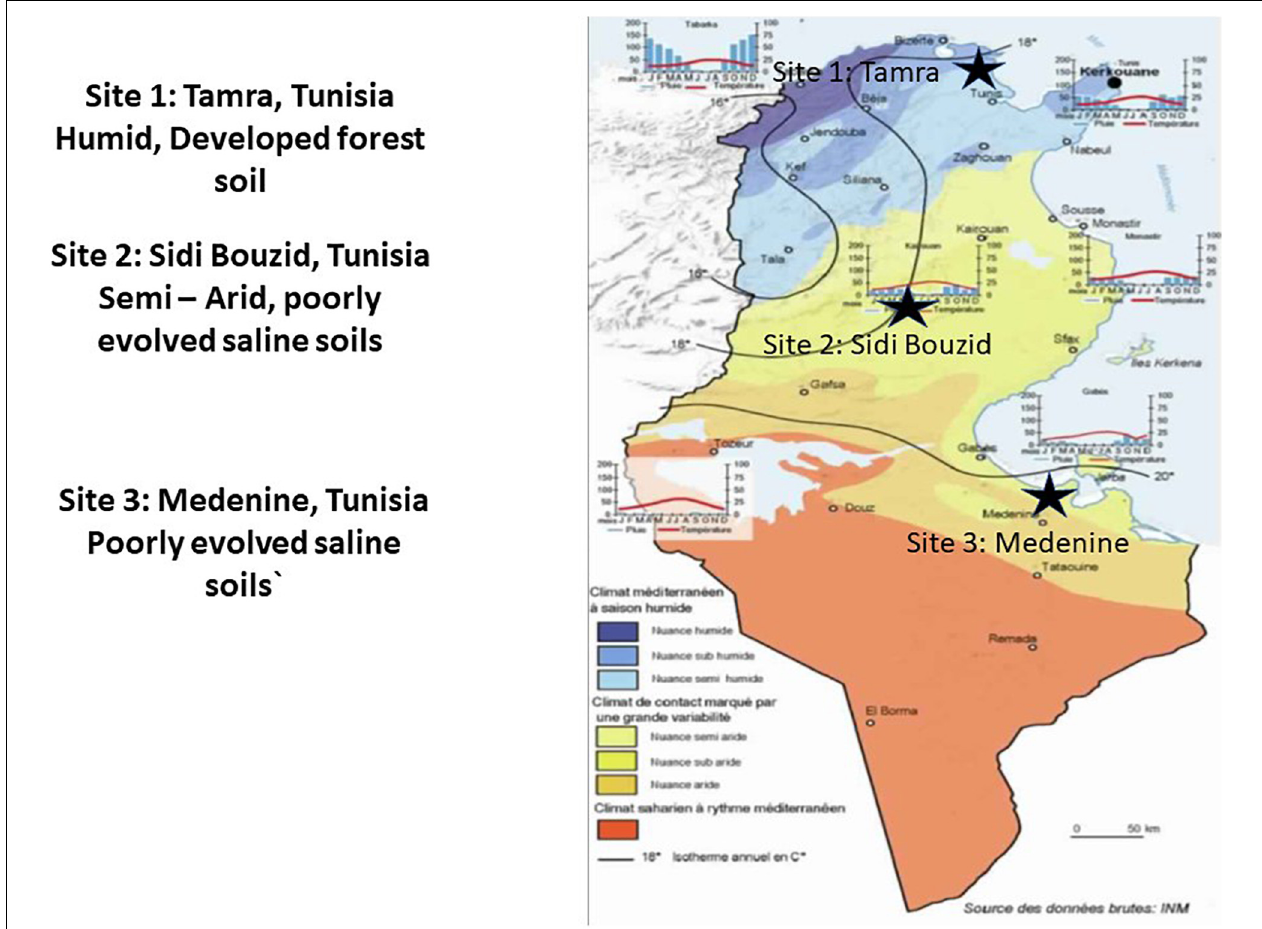
FIGURE 1 | Map and schematic of amplicon survey sampling design: For each sample type from each site, 3 replicates were sampled. Modified from Hénia